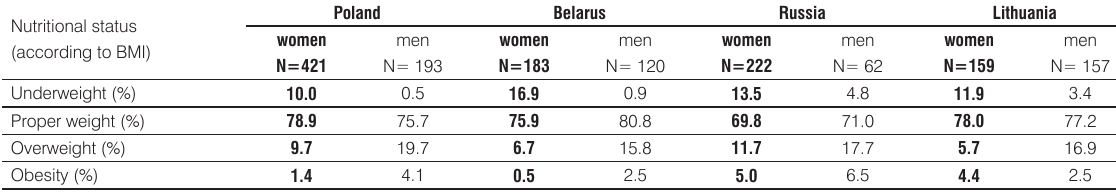
Table 3. The distribution of BMI classes by country in women and